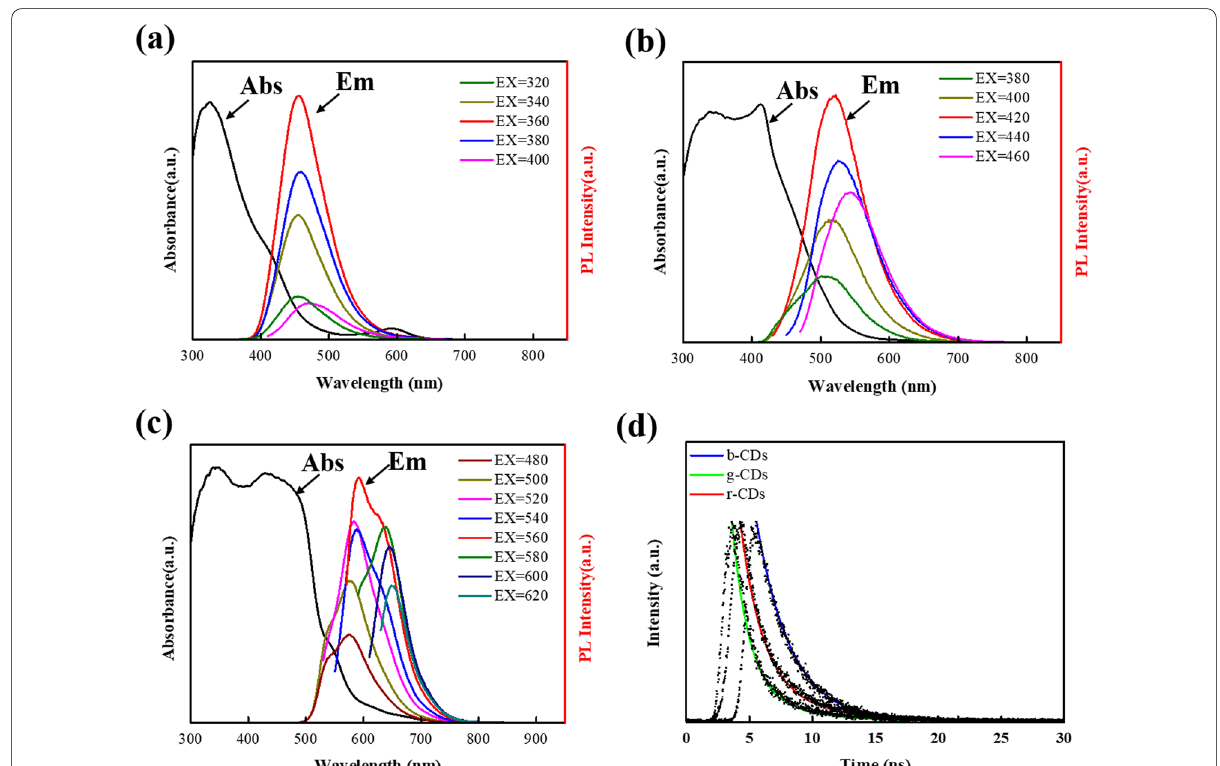
Fig. 5 UV/Vis and PL emission spectra of b-CDs ( a ), g-CDs ( b ) and r-CDs ( c ). d PL decay curves of b-CDs, g-CDs and